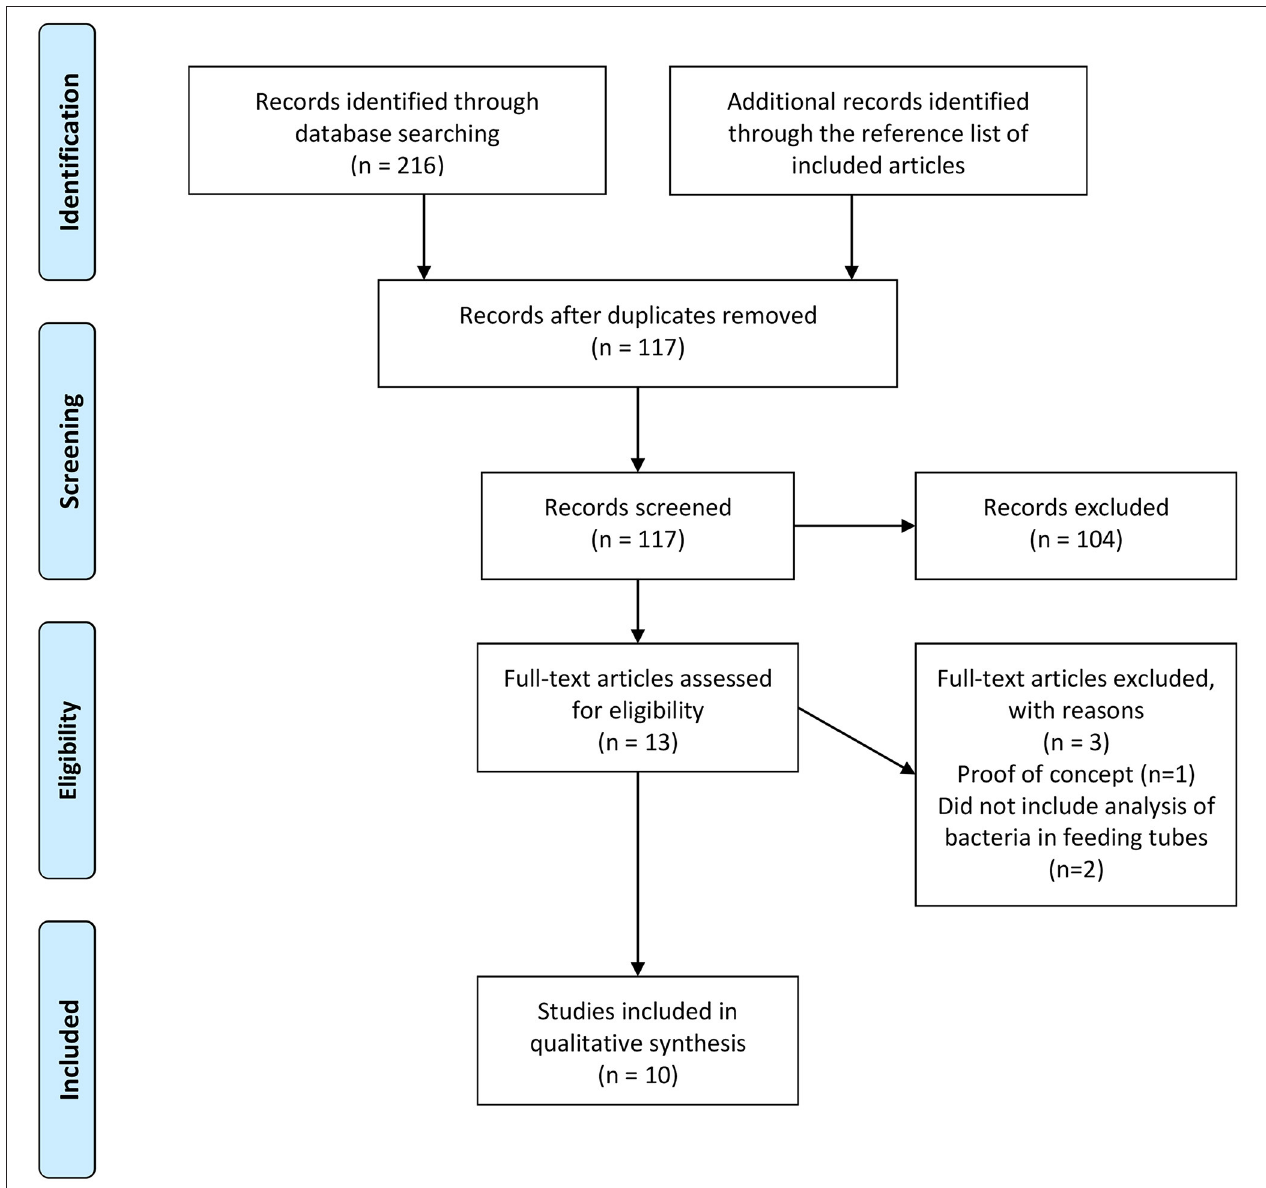
FIGURE 1 | Flow diagram of search strategy and study